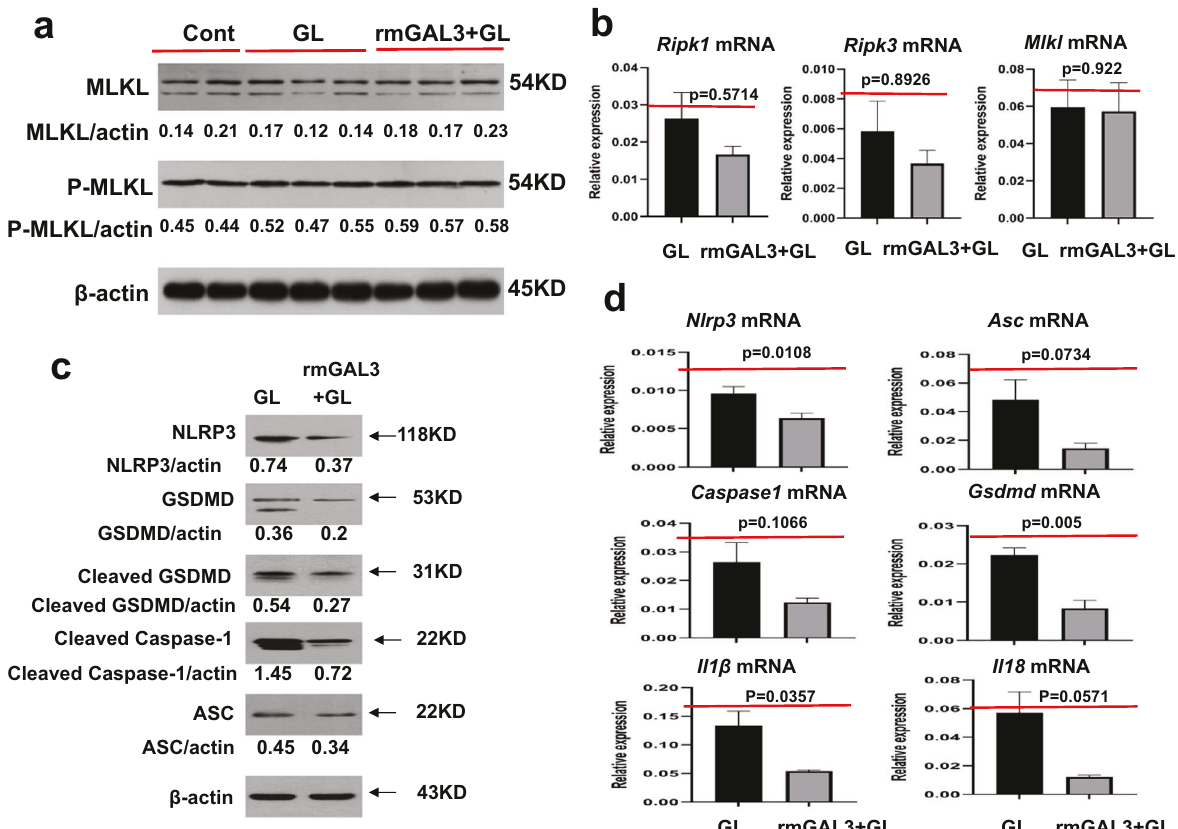
Fig. 6 GAL3 exerts hepatoprotection in acutely injured mice by inhibiting pyroptosis but not necroptosis signalling. a The protein expression levels of necroptosis signalling molecules, including MLKL and p-MLKL, as detected by western blot in the livers of control and acutely injured mice with or without recombinant GAL3 treatment. b The mRNA expression levels of necroptosis signalling molecules, including Ripk1 , Ripk3 and Mlkl , in the livers of control and acutely injured mice with or without recombinant GAL3 treatment ( n = 6 – 7). c The protein expression levels of pyroptosis signalling molecules, including NLRP3, GSDMD, cleaved GSDMD, ASC and cleaved caspase-1, as detected by western blot in the livers of control and acutely injured mice with or without recombinant GAL3 treatment. d The mRNA expression levels of pyroptosis signalling molecules, including Nlrp3 , Gsdmd , Asc , Caspase1 , Il1 β and Il18 , in the livers of control and acutely injured mice with or without recombinant GAL3 treatment ( n = 4 – 6). Group comparisons were performed using Student ’ s t test or the Mann – Whitney U